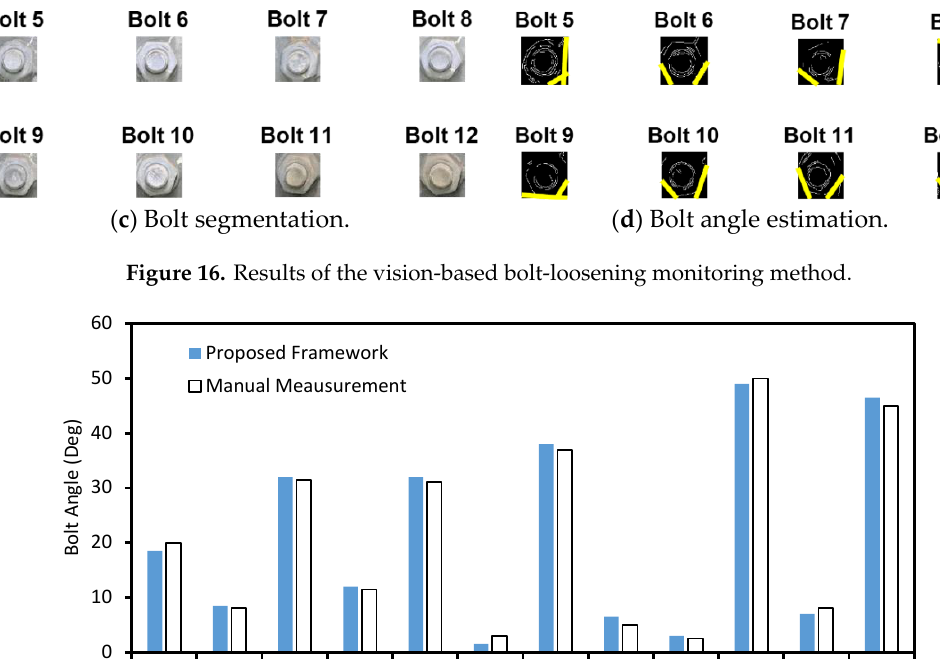
Figure 17. The accuracy of the bolt angle estimation of the repaired bolted connection.